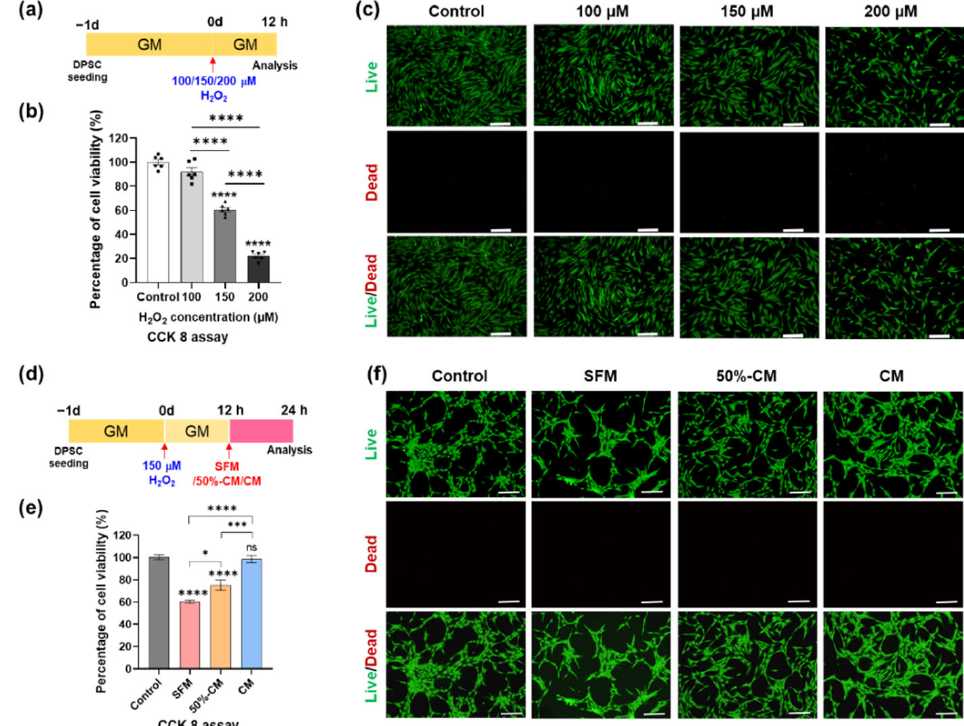
Figure 2. Treatment with hGF-CM improves DPSC viability after H 2 O 2 exposure. ( a – c ) DPSC viabil- ity exposed to different concentrations (100, 150, and 200 µ M) of H 2 O 2 for 24 h. ( a ) Schematic image of the timetable for the viability test depending on the H 2 O 2 concentration. ( b ) Quantified